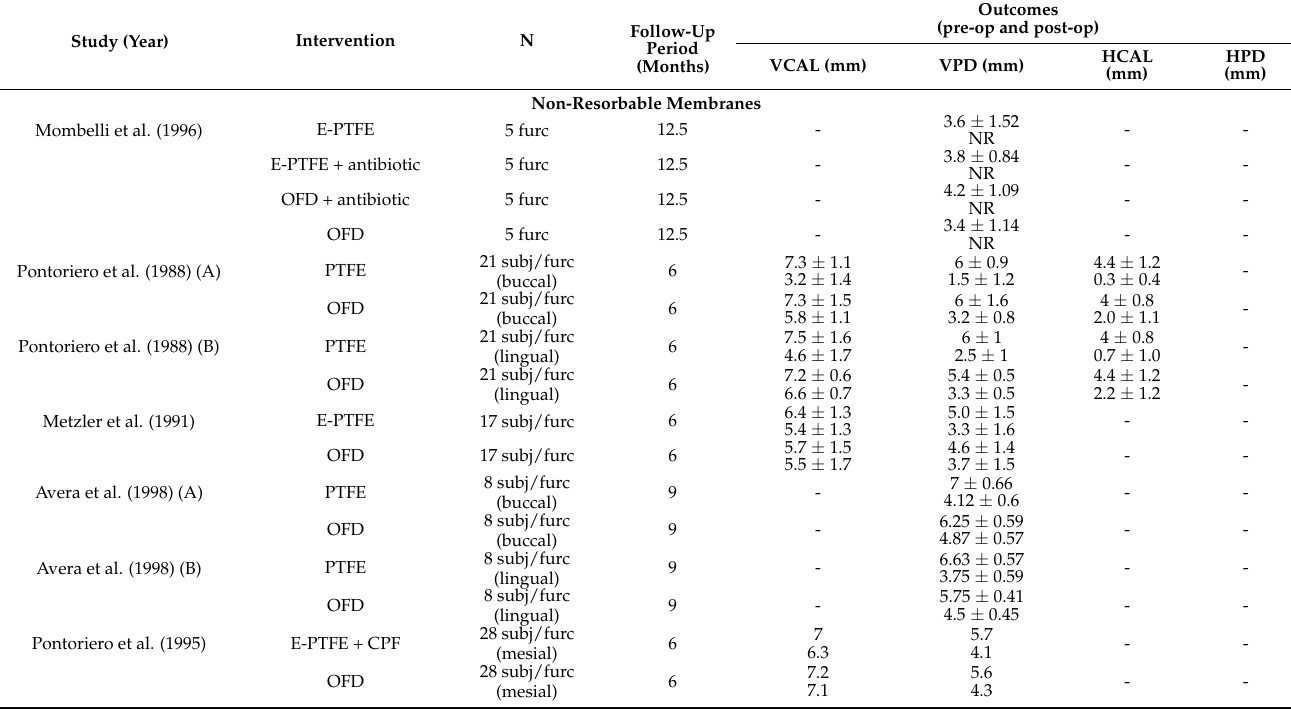
Table 3. Results reported at baseline and at follow-up in papers where non-resorbable membranes were used.